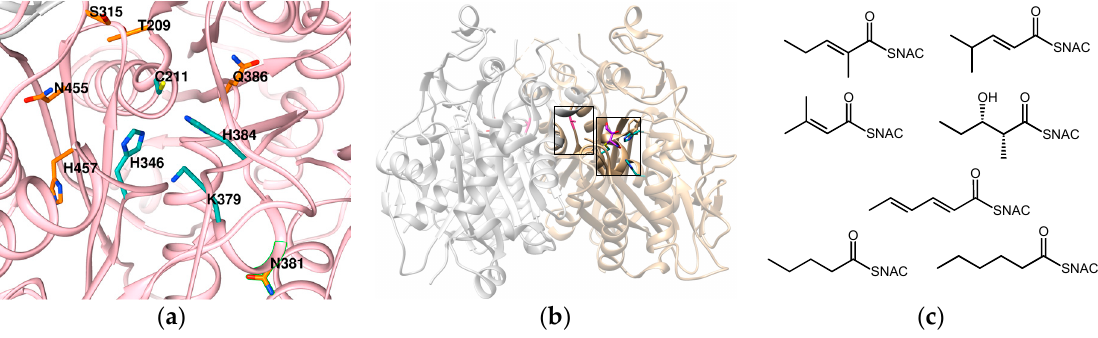
Figure 6. ( a ) Homology model of the active site of KS1, prepared using SWISS-MODEL [64] with DEBS KS3 as a template. Catalytic residues are in cyan, and the orange residues are conserved residues that were also investigated by Robbins et al.; ( b ) Location of alanine residue on the DEBS KS3 dimer interface loop (PDB: 2HQO3). Mutation of this alanine to a tryptophan greatly expanded the substrate range of DEBS KS3; ( c ) Seven new substrates that previously could not be processed by DEBS KS 3. Note that the alanine (pink) is farther away from the active site (shown with residues colored cyan and purple).